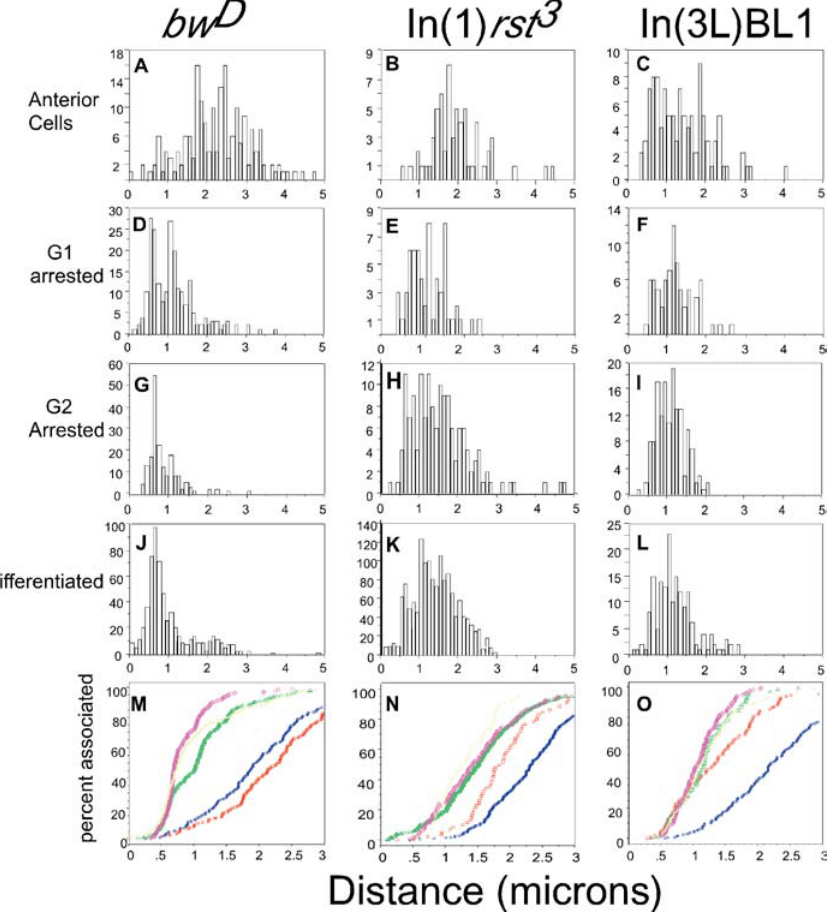
Figure 6. Differentiation Is Not Required for Association Physical distances in microns between heterochromatic probe signals and P1 probe signals were measured for each line and sorted based upon staining for G2